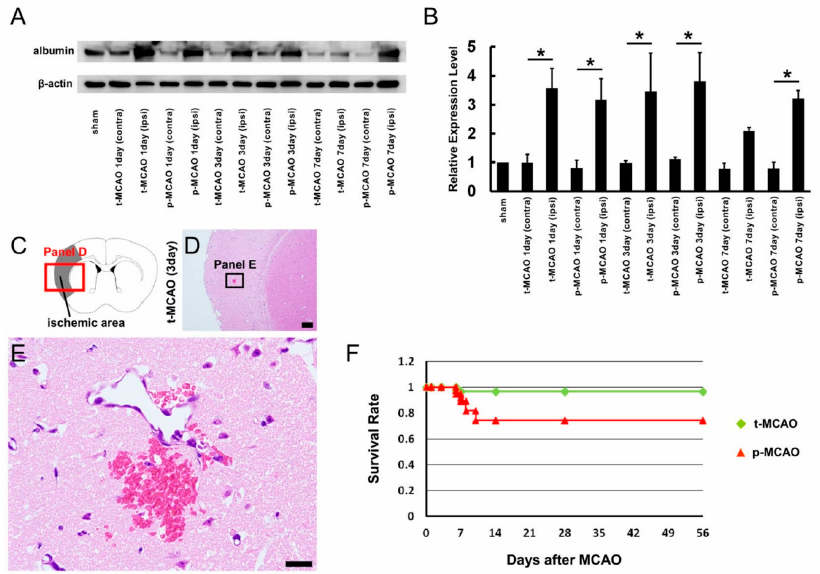
Figure 8. Western blot analysis of albumin expression in brain samples obtained from ipsilateral ischemic or contralateral non ischemic MCA areas after 90-min t-MCAO and p-MCAO ( A , B ). At 1 and 3 d post stroke, albumin expression levels in the ipsilateral ischemic MCA areas were significantly greater than in the contralateral non-ischemic MCA areas after 90-min t-MCAO and p-MCAO ( B ). At 7 d post stroke, albumin expression levels in the ipsilateral ischemic MCA areas were significantly greater than in the contralateral non-ischemic MCA areas after p-MCAO, but not 90-min t-MCAO ( B ). H&E staining was performed for mice after 90-min t-MCAO and p-MCAO. H&E staining indicated hemorrhagic transformation after 90-min t-MCAO at 3 d post stroke. ( n = 18, for each model) ( C – E ). A Kaplan–Meier curve showed that survival rates were not significantly di ff erent between the stroke models ( n = 49 for t-MCAO, n = 56 for p-MCAO) ( F ). * p < 0.05 between brain regions ( B ) ( n = 3, for each sample). Scale bars = 200 µ m ( D ) and 20 µ m ( E ). Abbreviations: contra, contralateral; H&E,